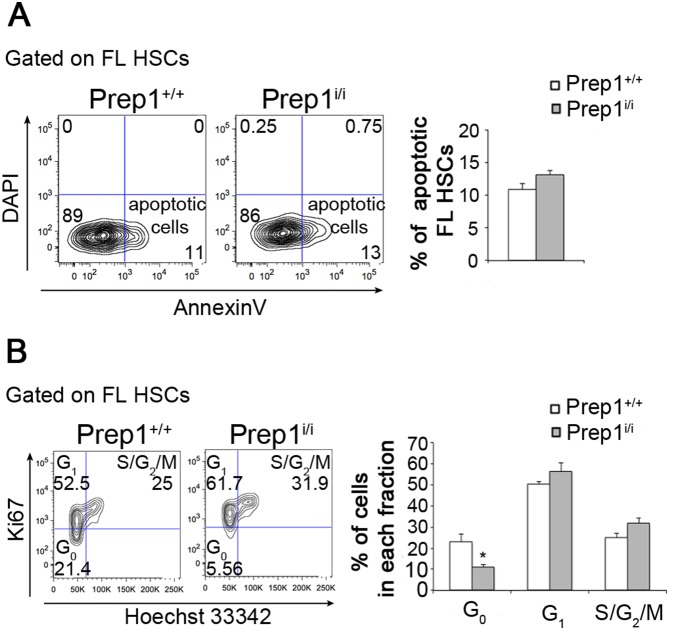
Prep1 influences HSC quiescent pool rather than HSCs apoptosis.(A) Representative FACS contour plots to identify apoptotic Prep1+/+ and Prep1i/i HSCs are shown on the left. The represented plots refer to L−S+K+CD150+ gate and numbers in the FACS plots indicate the percentage of cells in parental gates. On the right, the graph represents the mean of apoptotic HSCs (Annexin+ DAPI−) (n = 3; p = not significant). (B) Representative FACS contour plots to identify the cell cycle distribution of Prep1+/+ and Prep1i/i HSCs are shown on the left. The represented plots refer to L−S+K+CD150+ gate and numbers in the FACS plots indicate the percentage of cells in parental gates. On the right, the graph represents the mean of G0 (Ki67−Hoechstl°w), G1 (Ki67+Hoechstl°w) and S/G2/M (Ki67+Hoechsthi) HSCs (n = 3; p = not significant) (n = 3; G0 p = 0.02; G1 and S/G2/M p = not significant).